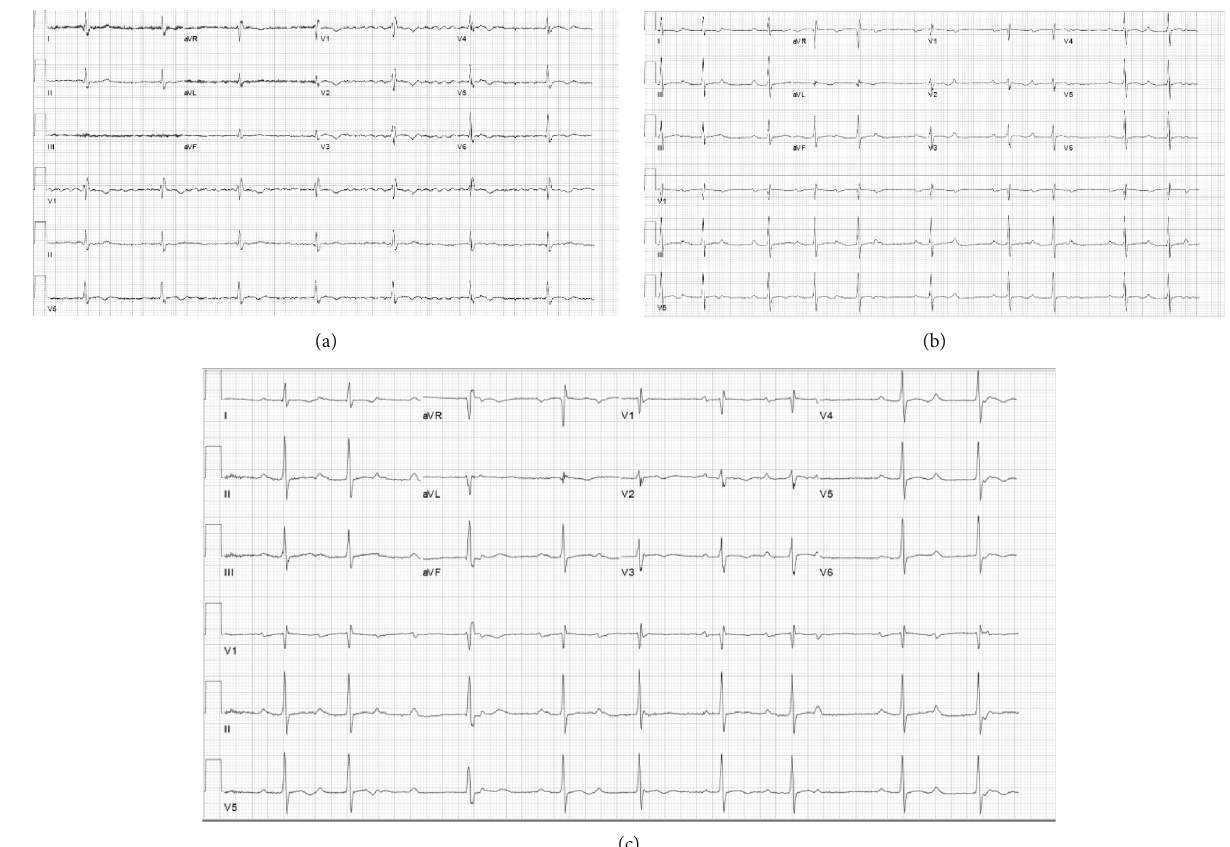
Figure 1: ECG of variable heart block in a patient with cardiac sarcoidosis: (a) baseline atrial fi brillation with junctional escape rhythm; (b) second-degree Mobitz type 1 AV block; (c) high grade AV